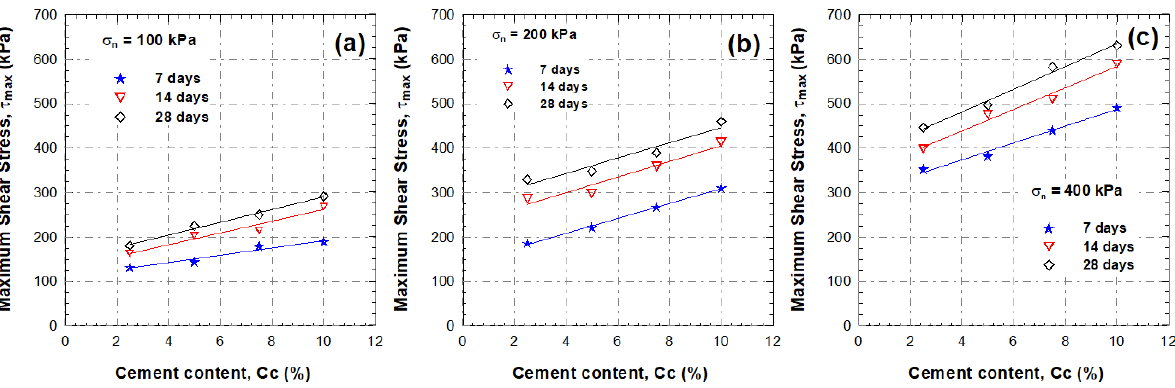
Figure 11: Influence of cure time on the maximum shear strength of cemented sand, (a) Normal stress of 100 kPa, (b) Normal stress of 200 kPa, (c) Normal stress of 400 kPa,.